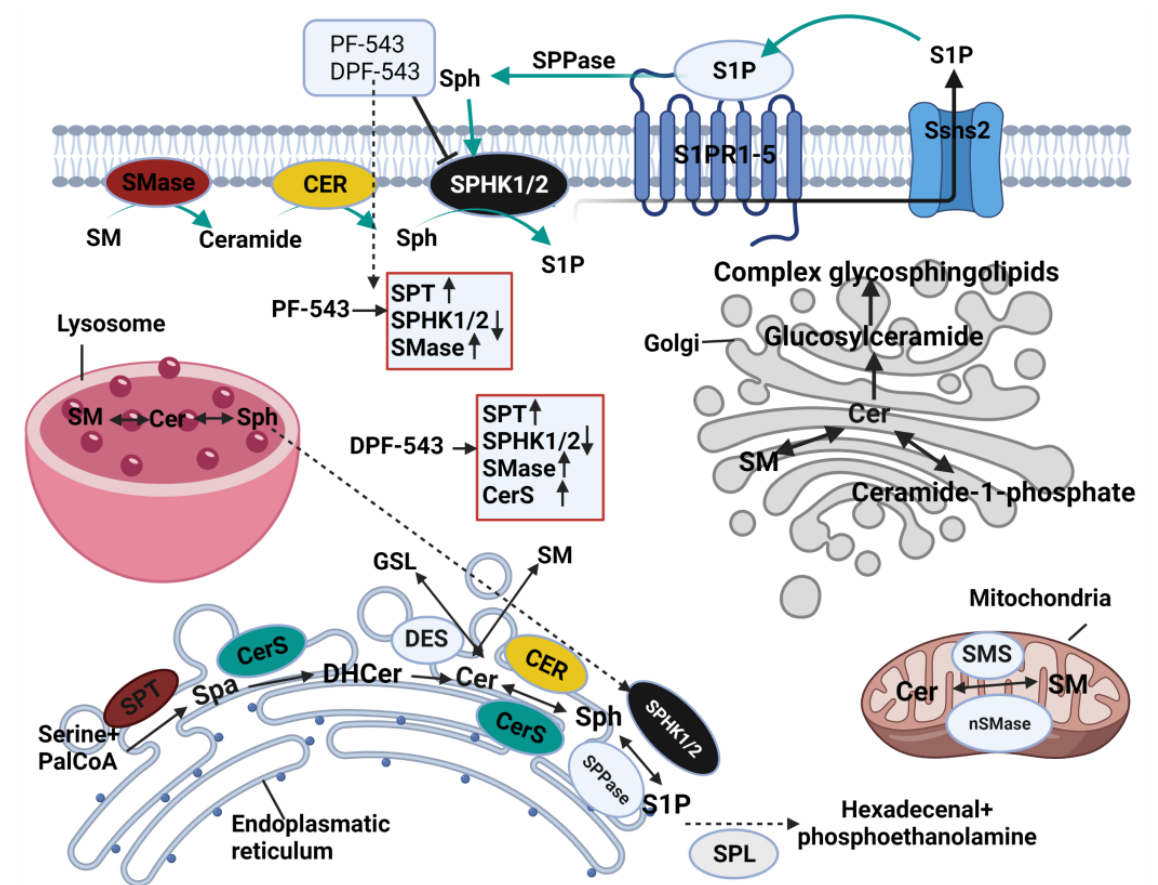
Figure 10. Action mechanism of PF-543 and DPF-543 on cellular sphingolipid metabolism. Figure was created by BioRender.com, accessed on 3 August 2021. Enzyme colors were defined based on inhibitor action: If the both chemical inhibits: Black; If the both inhibitor activate: Burgundy; If PF543 only activates: Yellow; If DPF543 only activates: Sky blue.